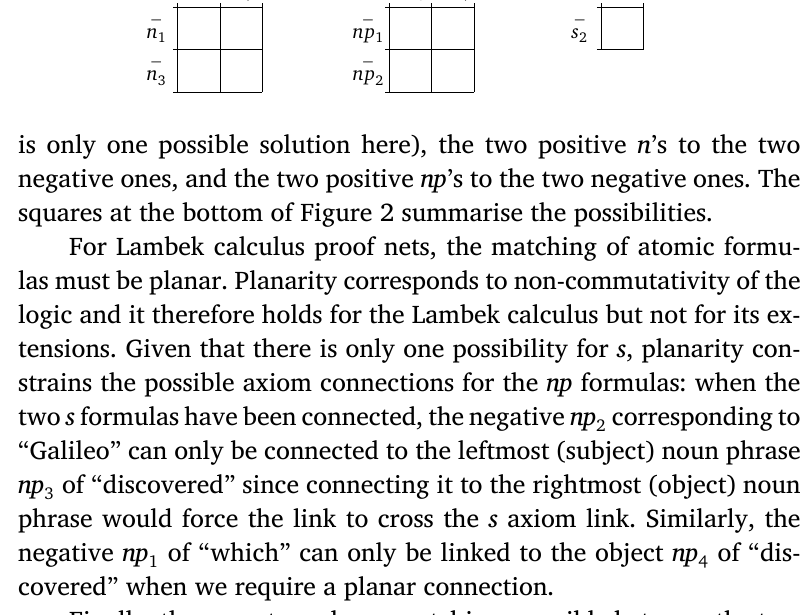
Figure 2: Formula unfolding for “moons which Galileo